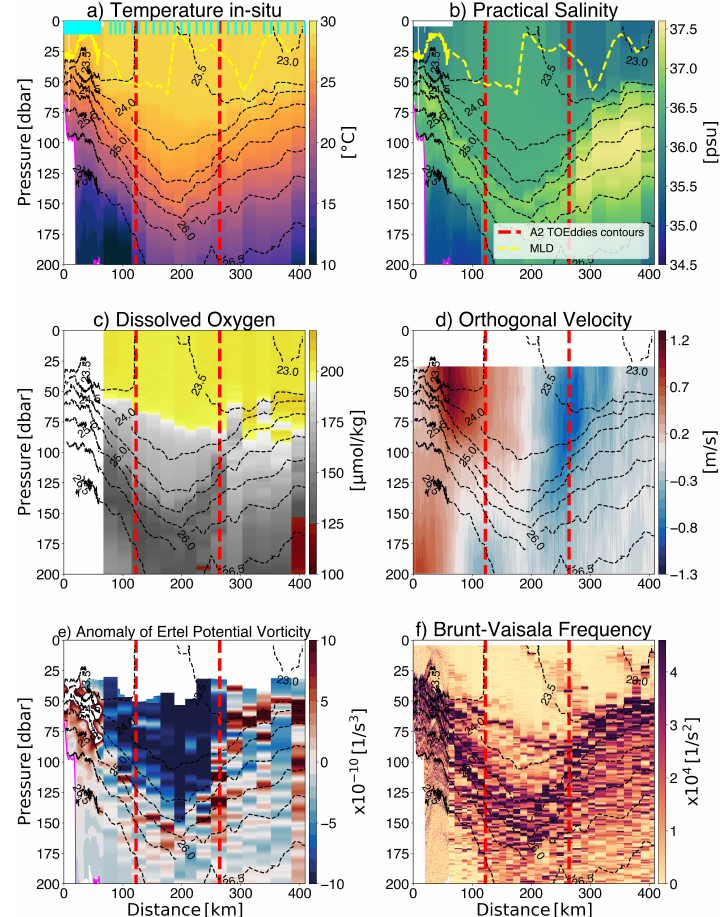
Figure 4. Ring A2 section performed by R/V L’Atalante during the EUREC 4 A-OA experiment, between 27 and 29 January 2020. Red contours indicate the ring maximum velocity contours de- tected by TOEddies. The dotted black lines are isopycnals, computed by combining cross-validated CTD, uCTD, and MVP devices (the profile positions are indicated by cyan bars on the first panel). The magenta line varying vertically indicates that below it, only CTD measurements are represented. The yellow dashed line corresponds to the mixed layer depth